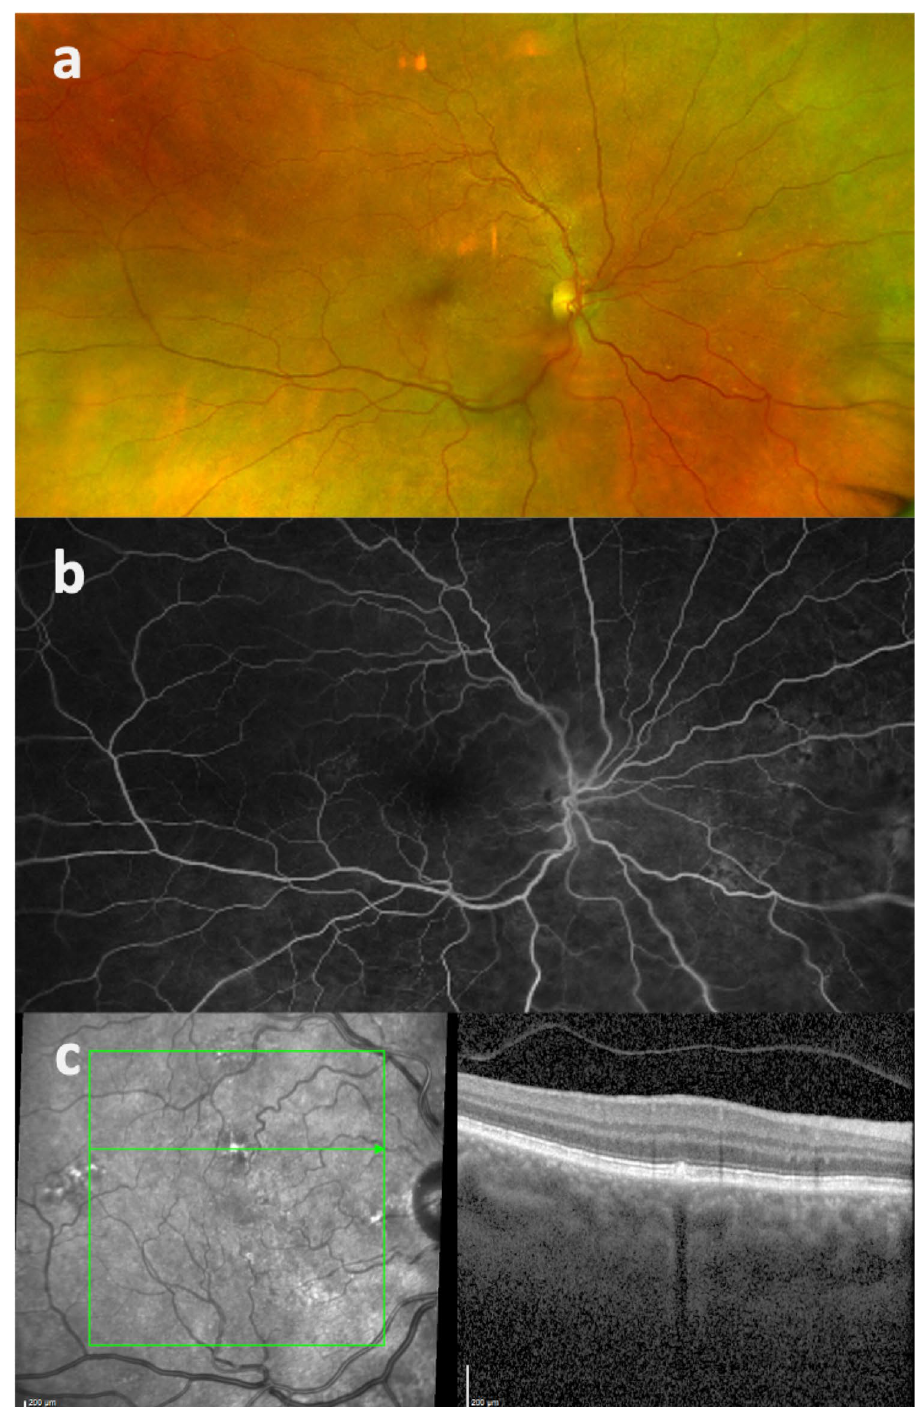
Figure 2. Multimodal imaging of a partner eye of an eye with acute CRVO. Fundus photography ( a ), fluoresceine angiography ( b ) (Optos system, Dunfemline, UK) and OCT-B scan ( c ) at the level of the